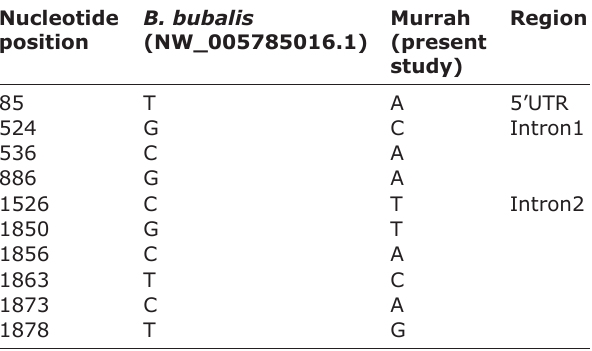
Table-2: SNPs in PPP1R11 gene in Murrah buffalo. Nucleotide